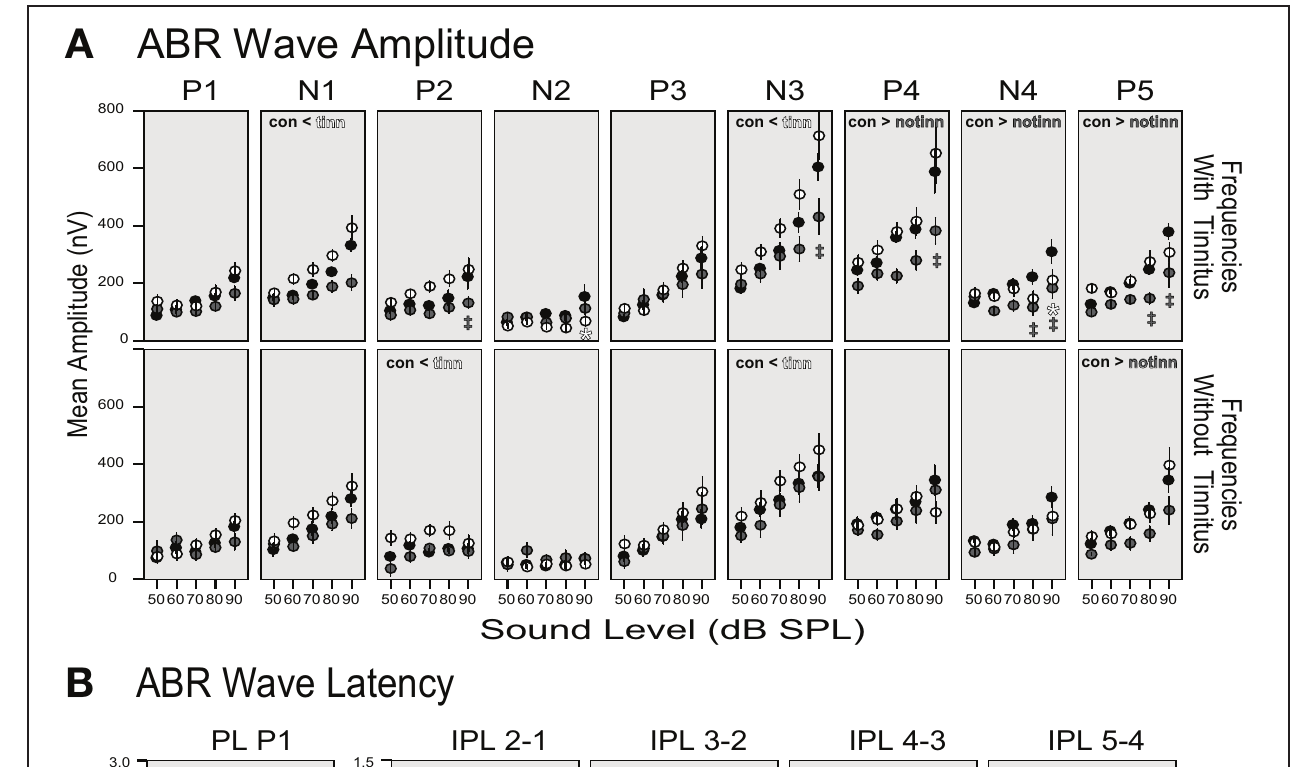
with < or > in the respective panel ( p < 0 . 05, linear mixed model statistics with pairwise comparisons of groups across dB level) and significant differences for single levels are indicated with ∗ (tinnitus vs. control group) and with ‡ (no-tinnitus vs. control; p < 0 . 05, linear mixed model statistics with pairwise comparisons at each level). For details see Methods. P1, P2, P3, P4, P5: positive wave peaks, N1, N2, N3, N4: negative wave troughs, PL: peak latency, IPL: interpeak latency, measured between the positive wave